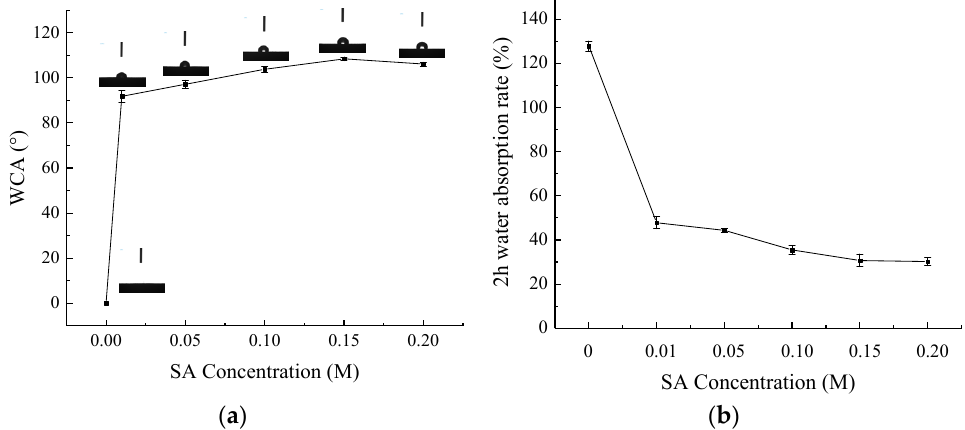
Figure 6. The water contact angle ( a ) and 2 h water absorption rate ( b ) of modified NP with different SA